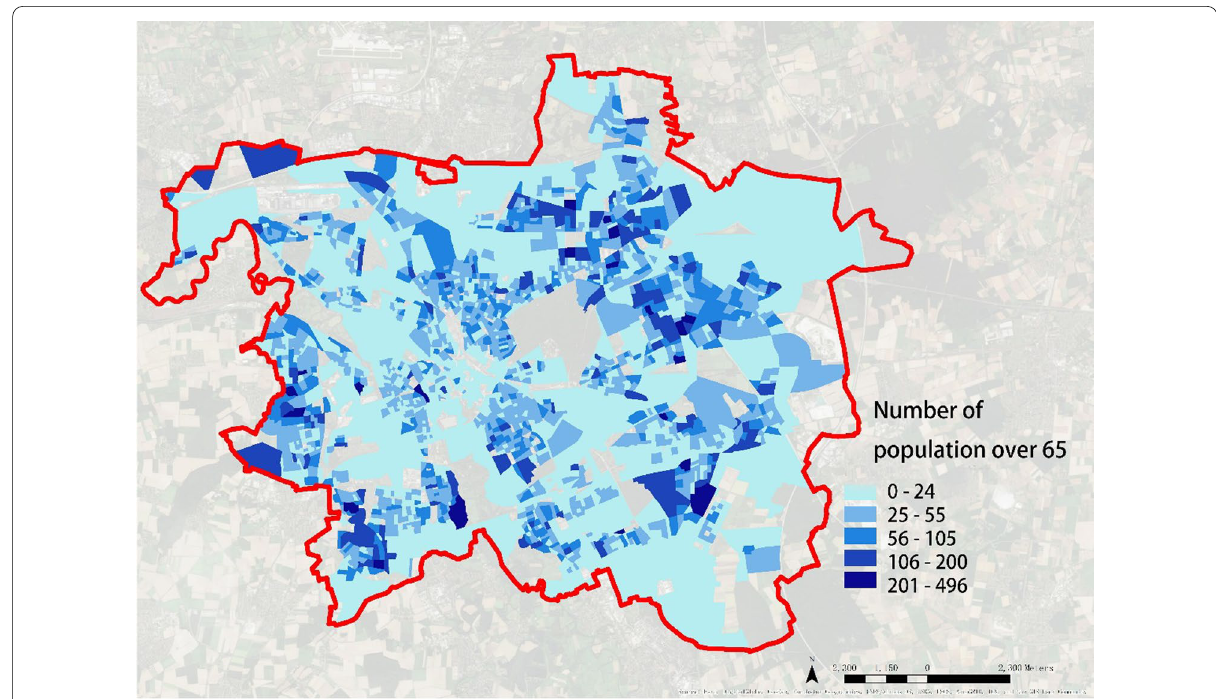
Fig. 1 Distribution of elderly people over the age of 65 in Hannover at the census block level (source: The City of